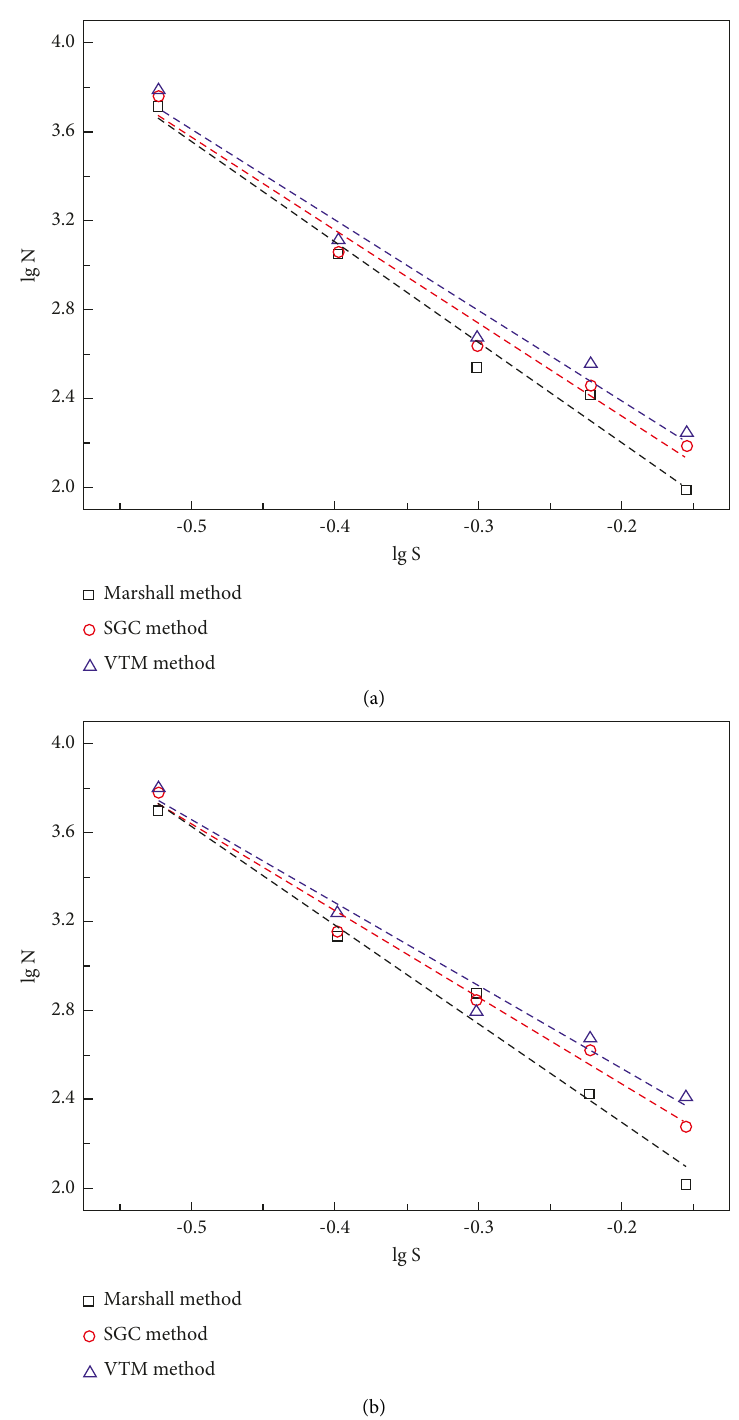
Figure 10: Equivalent fatigue life versus stress level at different gradation. (a) Specification gradation. (b) Skeleton dense